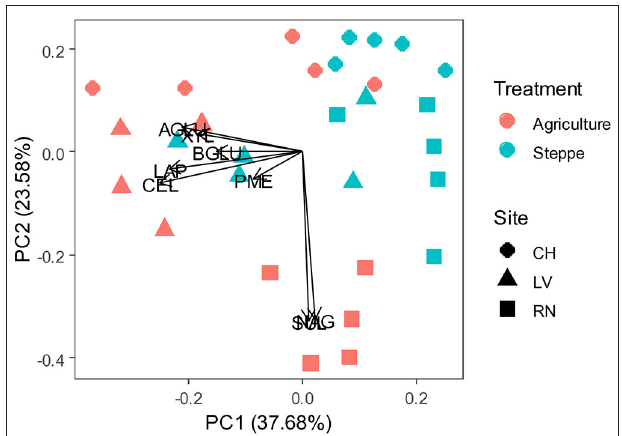
FIGURE 1 | Principal component analysis (PCA) of soil enzymatic pattern response to irrigated agriculture and steppe soils. CEL, β -cellobiohydrolase;